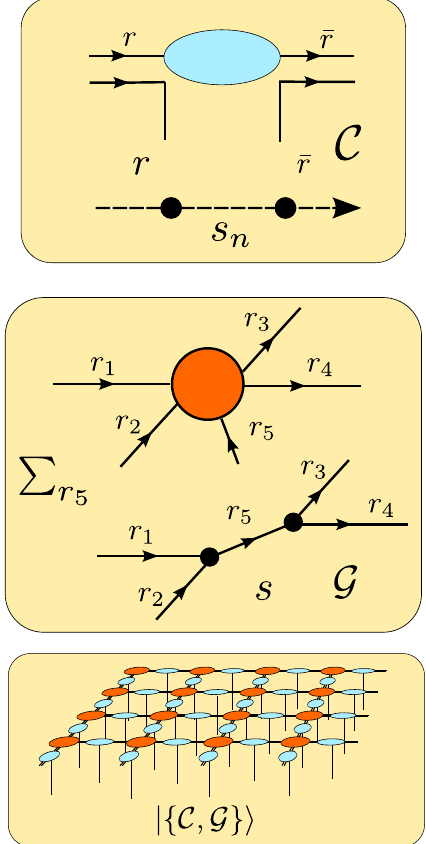
FIG. 20. (a) The C tensor used to build a variational ansatz for a gauge-invariant state. The tensor acts on a link s and embeds its n state onto the auxiliary space. It is composed by two parts, a “ symmetry part ” that does not contain any variational parameter (the two lower lines) and a degeneracy part that contains the variational parameters (the cyan tensors). The tensor has several blocks labeled by the irrep r . (b) The G tensor only acts on the auxiliary space, and it has again a block structure. It is divided in two pieces. The first is responsible for the correct symmetry properties of G [see Fig. 15(a)]. This part does not contain any free parameters and is given in terms of the Clebsch-Gordan coefficients of the group (small black dots). The second part is a degeneracy part that is formed by a sum of several tensors (one ⊗ D ⊗ D ⊗ D for each allowed value of r 5 ) acting on D . r 1 r 2 r 3 r 4 These tensors store the variational parameters of the G tensor in the appropriate symmetry blocks. (c) Variational ansatz for gauge-invariant states on a lattice of 4 × 4 sites and periodic boundary conditions. The network contains one C per link of the lattice and one G per site. The double lines connecting the tensors are used to remind readers that each of the elementary tensors has a double structure, one part dictated by the symmetry and the other one containing the actual variational parameters. In the figure, we are assuming the sum over all the irreps r on every bond of the TN, so that the specific irrep label is Fig. 20(c), where it is represented for the specific case of a